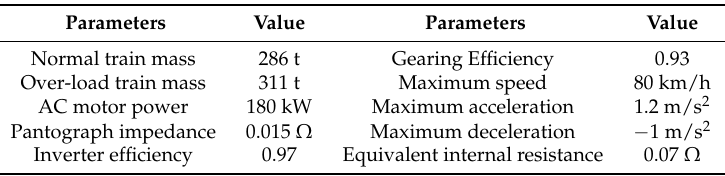
Table 1. Vehicle